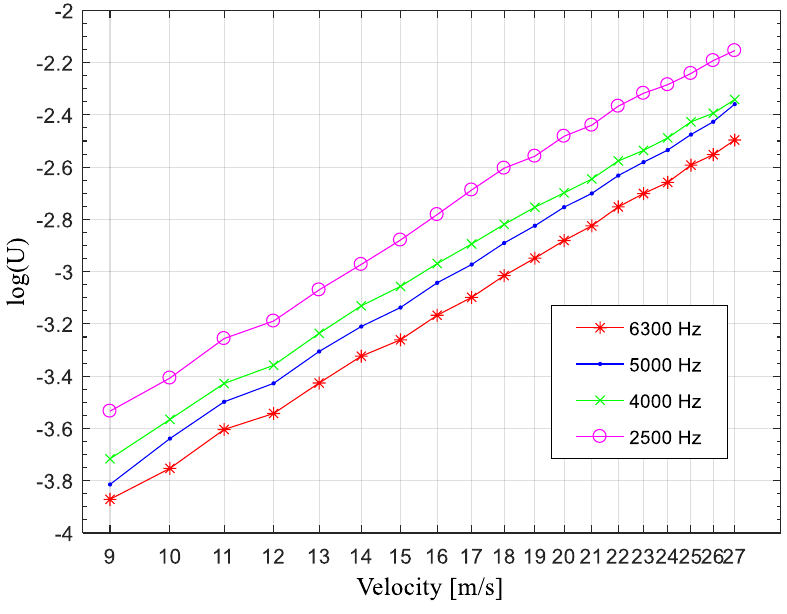
Figure 14. Variation of output with speed.